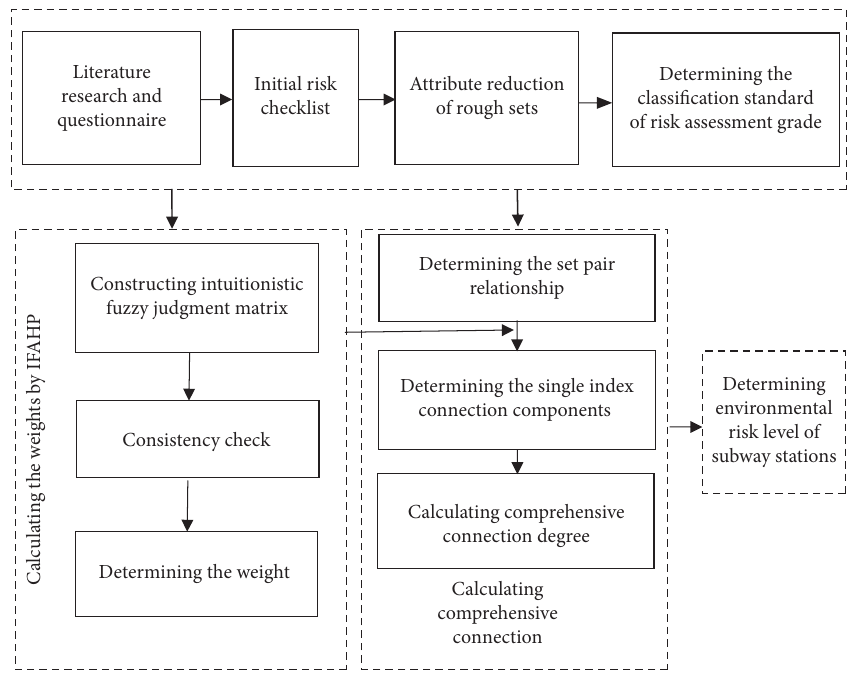
Figure 4: Flowchart of environmental risk assessment for subway station construction.